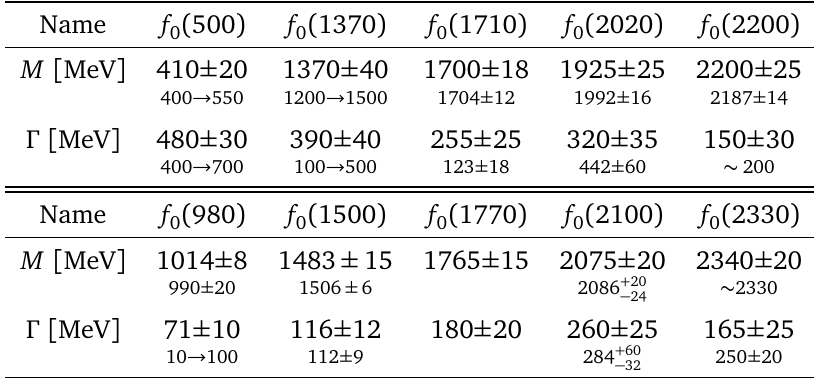
Table 1: Pole masses and widths (in MeV) of scalar mesons. The RPP values are listed as small numbers for